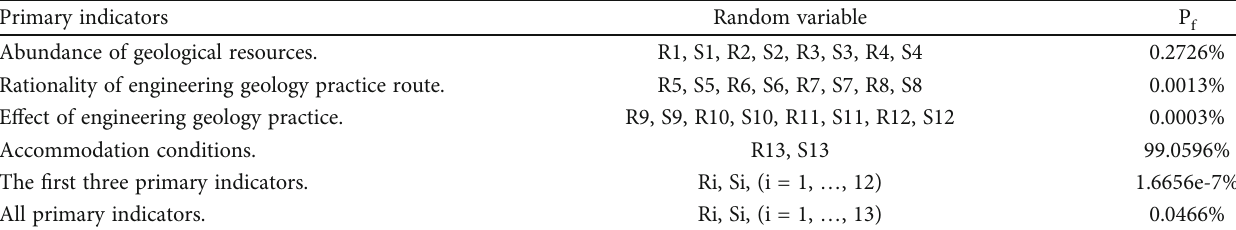
Table 4: Negative evaluation probability of engineering geology practice route with primary